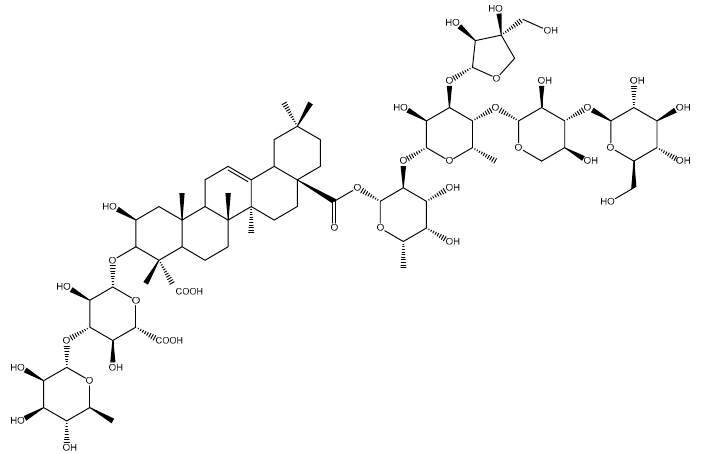
Figure 2. Chemical structure of herniariasaponin H.